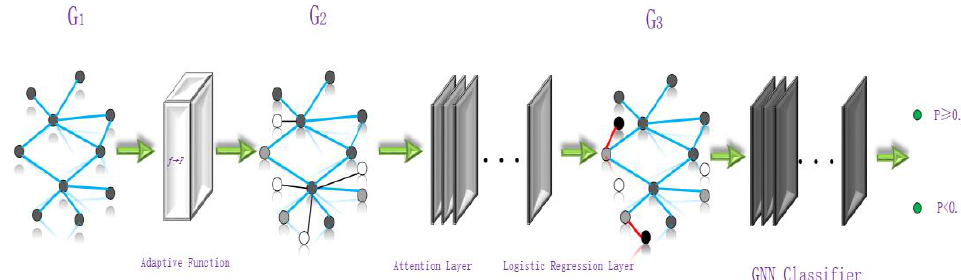
Figure 4. Flowchart of Scatter-GNN model.